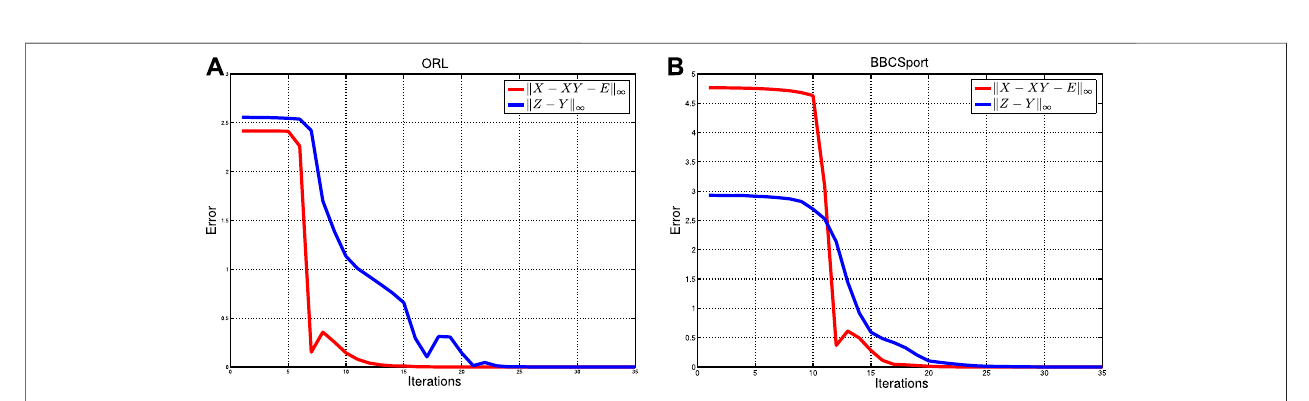
FIGURE 3 | Errors versus iterations on (A) ORL and (B) BBCSport